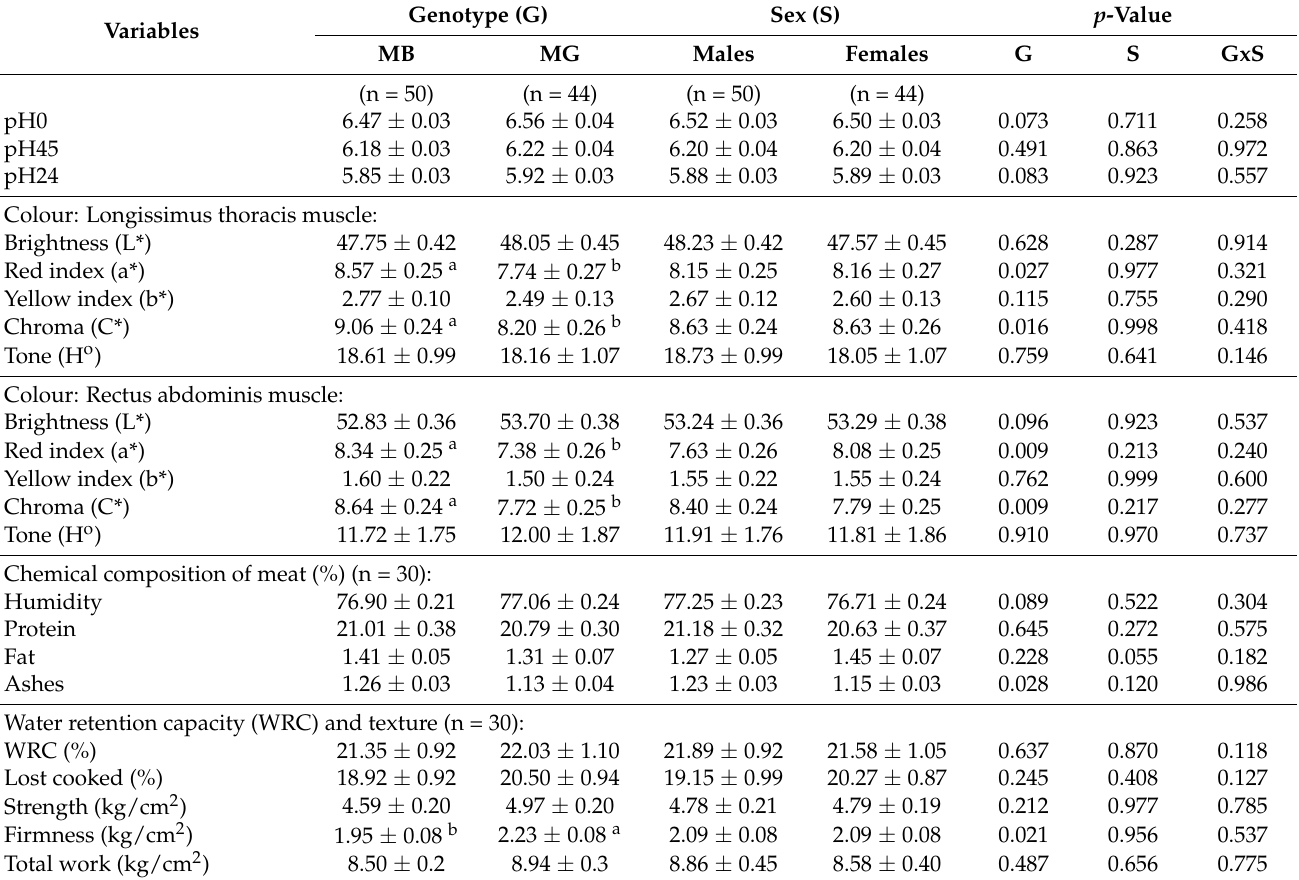
Table 5. Least-square means ( ± SE) for meat characteristics from kids according to genotype (purebred Murciano-Granadina (MG) or crossed with Boer (MB)) and